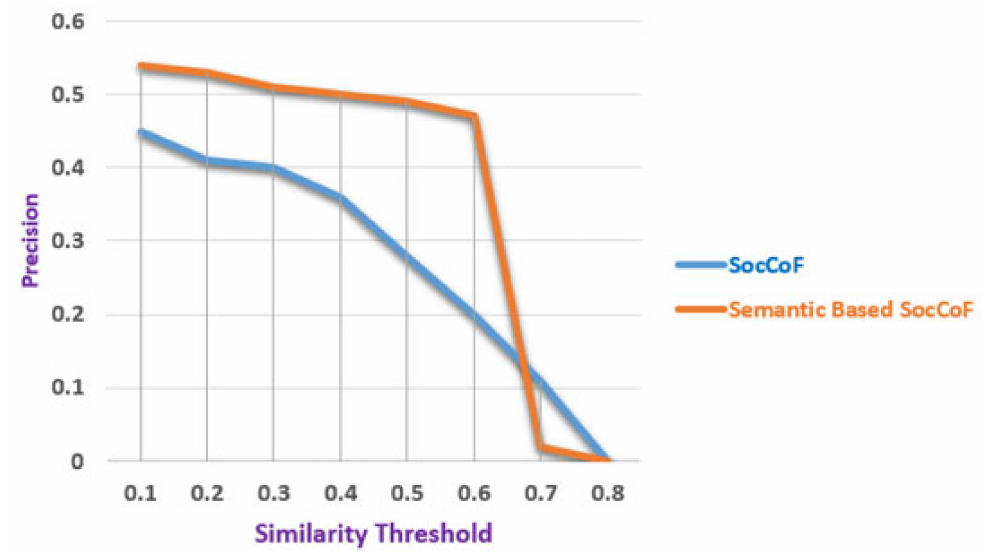
Figure 12. Precision of semantic-based SocCoF and SocCoF algorithms.